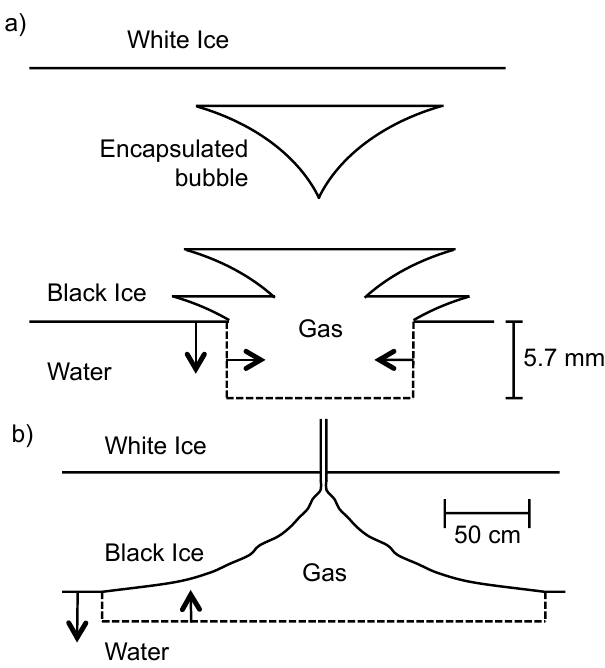
Figure 7. (a) A cross section of the model’s representation of trapped gas at A, B, and C seep sites. The dashed line indicates the area over which CH 4 dissolves into the water column. Gas be- neath the ice–water interface is modeled as a cylinder with constant height (5.7mm). The volume and radius of this cylinder decrease (indicated by arrows) as the ice grows downward and CH 4 diffuses out, giving rise to the tapering shape of encapsulated bubbles. (b) Schematic of a closed Hotspot seep site. The cavity’s shape is deter- mined by field measurements, and its bottom radius determines that of the cylinder of gas beneath the ice–water interface. The height of this cylinder decreases as CH 4 diffuses out and the ice grows down- ward (indicated by arrows). Note the different scales in (a) and (b)